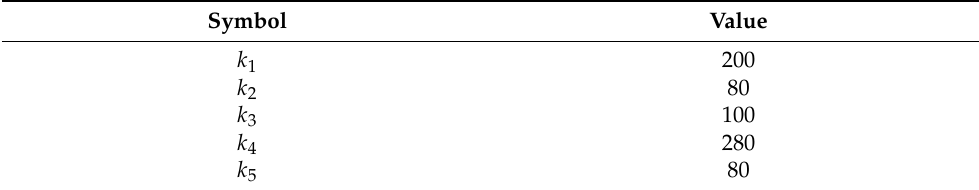
Table 5. The first set of backstepping control